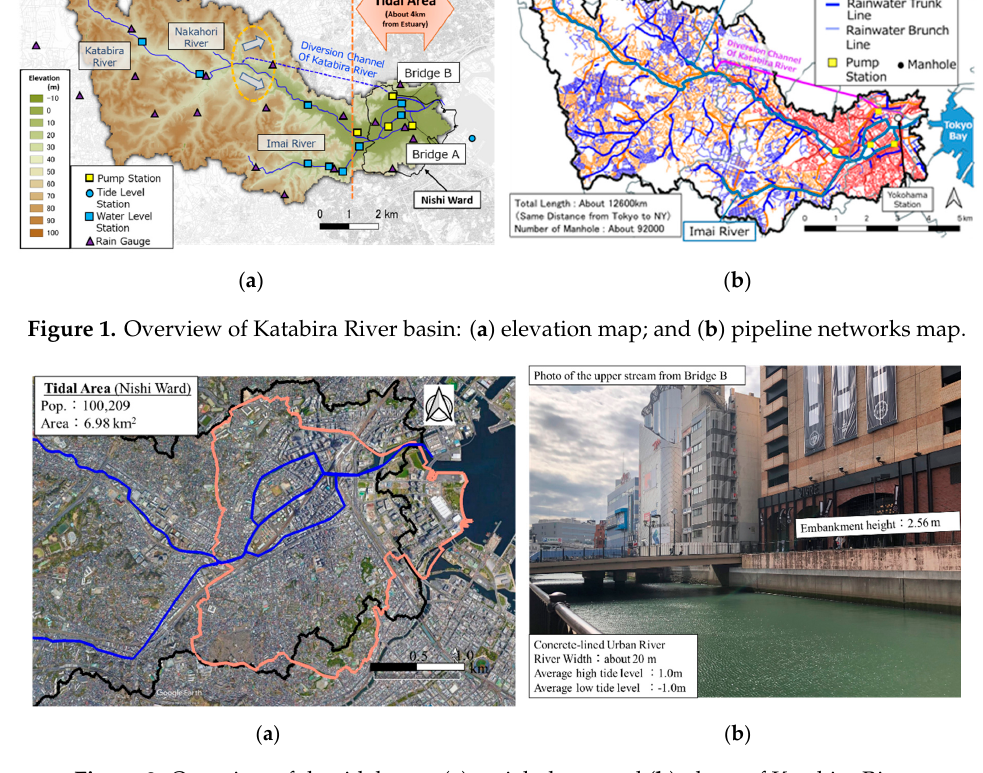
Figure 2. Overview of the tidal area: ( a ) aerial photo; and ( b ) photo of Katabira River.